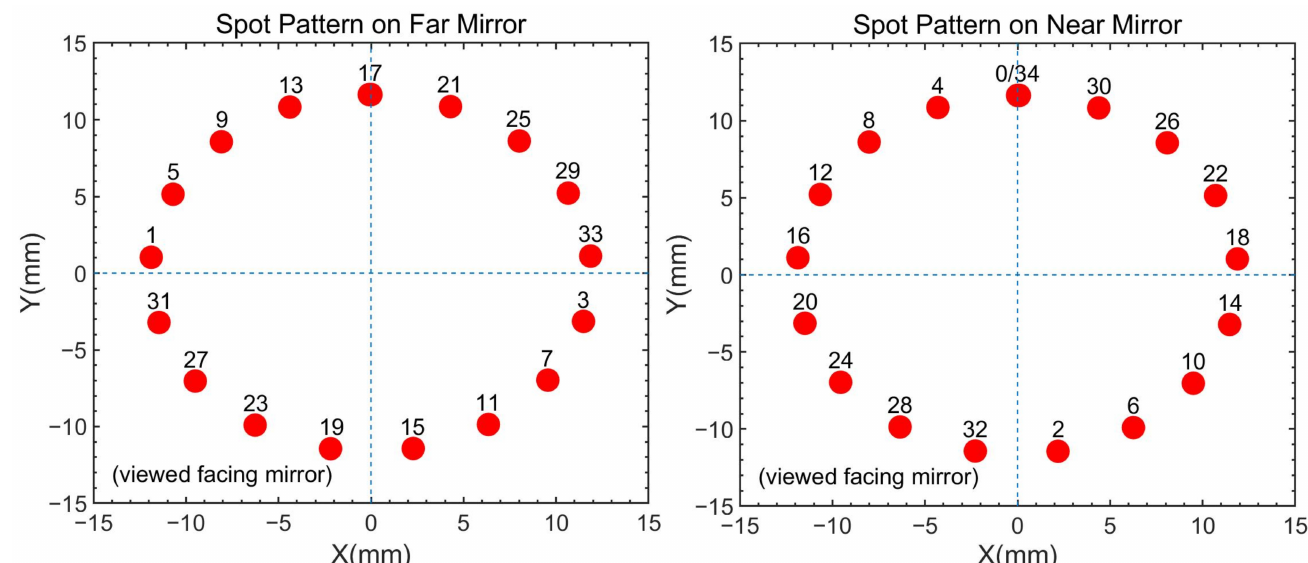
Figure 3. A schematic diagram of the spot patterns on the far and near mirrors of the HMPC with a correctly oriented input beam, from the perspective of directly facing each